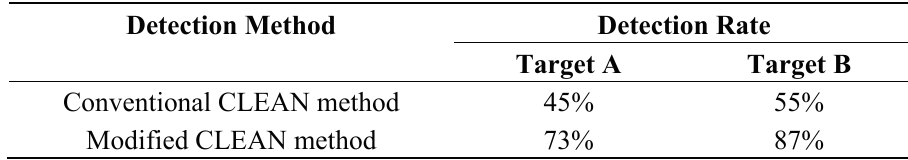
Table 4. Detection rates of two moving targets during the observed